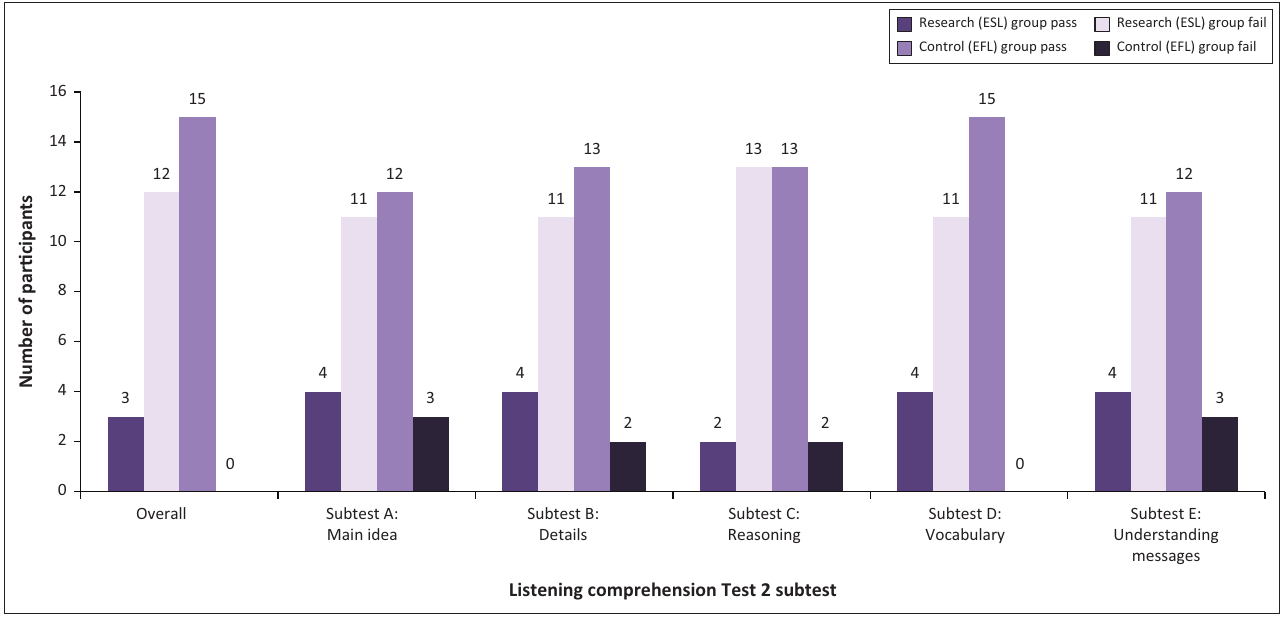
FIGURE 2: The number of participants in the English second language and, English first language groups who passed or failed the various sections of the children’s auditory processing performance scale questionnaire.